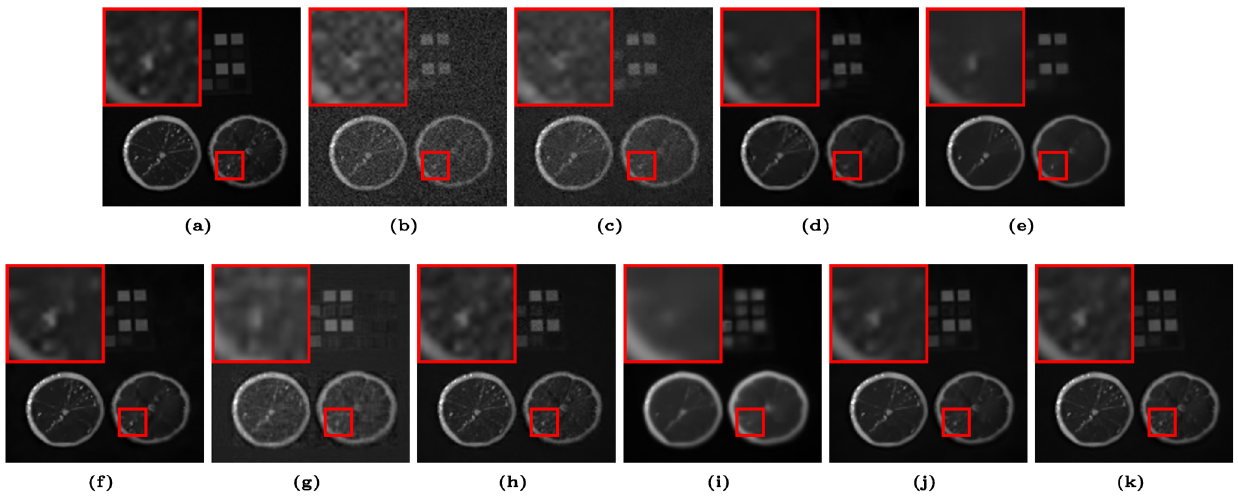
Fig. 2 Denoising results for one band of fake and real lemon slices using different methods. (a) Original image; (b) noisy image, variance = 0 . 05; (c) BW K-SVD [6]; (d) BW BM3D [7]; (e) ANLM3D [24]; (f) BM4D [13]; (g) PARAFAC [12]; (h) TDL [14]; (i) t-SVD [27]; (j) KBR [16]; (k) proposed.